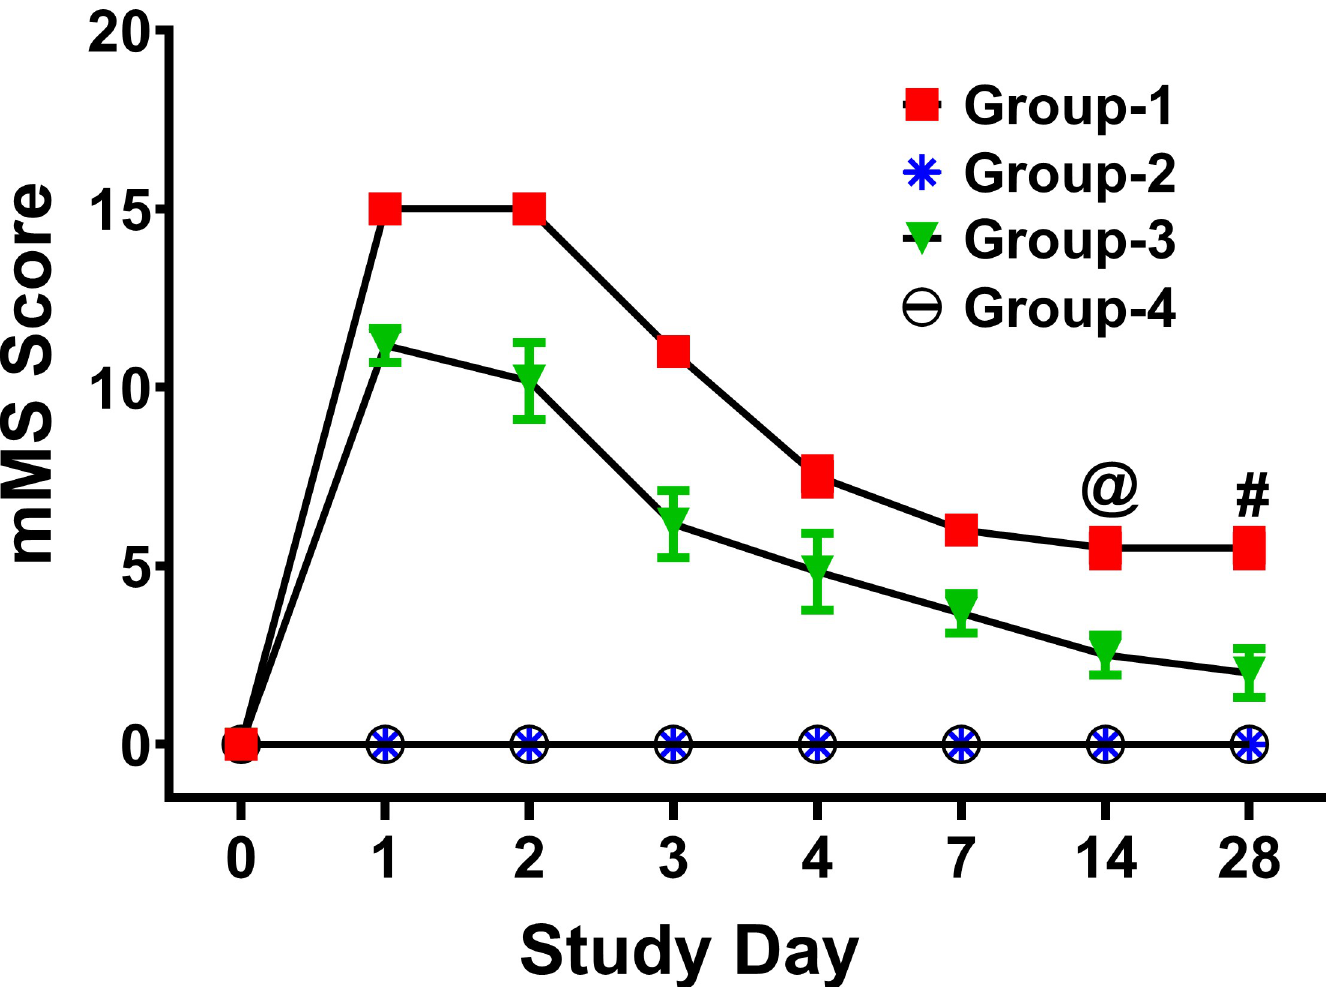
Fig 1. In vivo tolerability evaluation with modified McDonald Shadduck scoring (mMS). In safety evaluation, no significant difference in mMS scores between na ï ve eyes of Group-2 and unwounded eyedrop-treated eyes of Group-4 up to 28 days was observed. Conversely, alkali wounded eyes of Group-1 showed significant difference in mMS compared to the eyes of Group-3 at day-14 and day-28 (n = 6 for each group; @ = p value < 0.01; # = p value < 0.001).